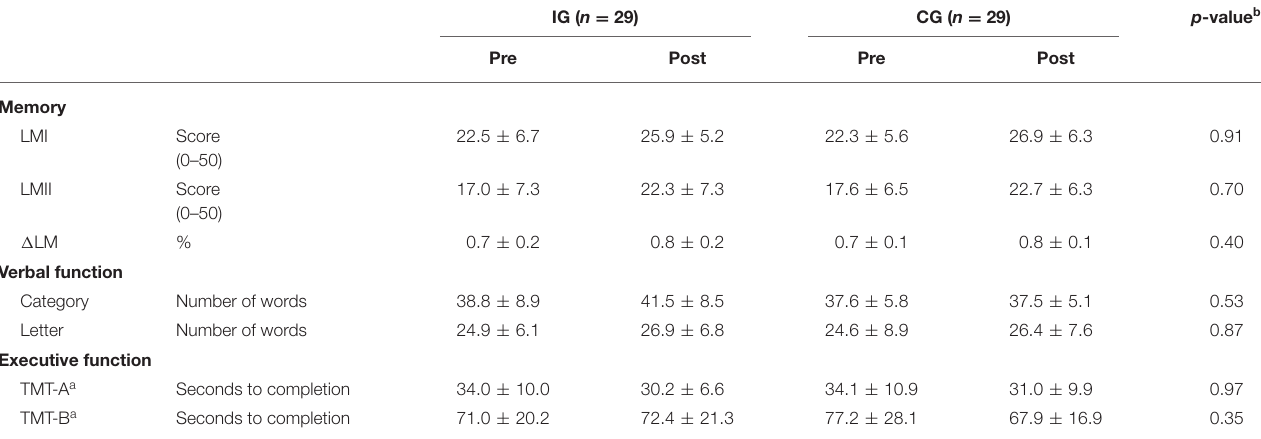
TABLE 2 | Cognitive test scores of participants who completed the pre-test and post-test.